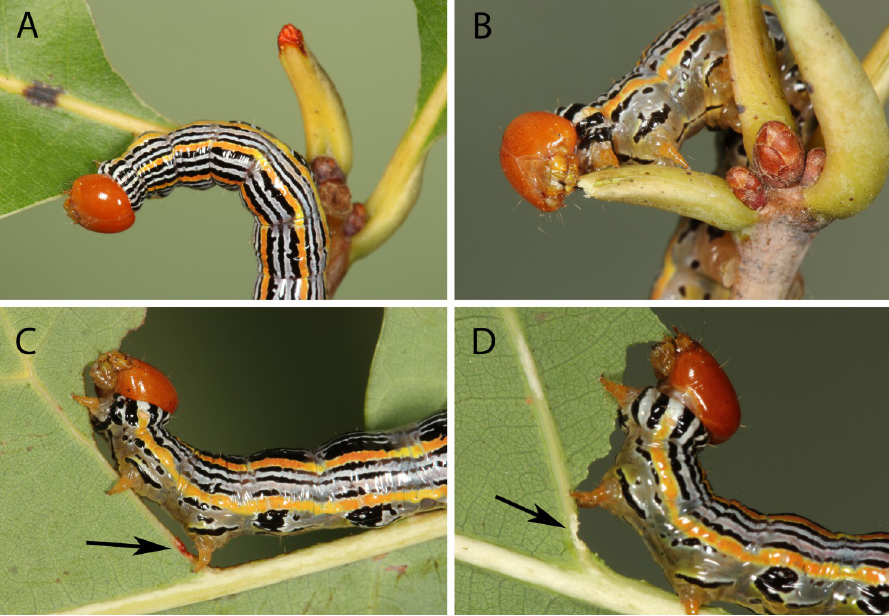
petiole and is wiping its mouthparts on the stub. No red fluid is visible because cautery blocked the opening of the labial glands preventing release of saliva. Intact (C) and cauterized (D) larvae feeding after chewing a furrow in leaf veins. Red saliva is visible only on the furrow cut by the intact